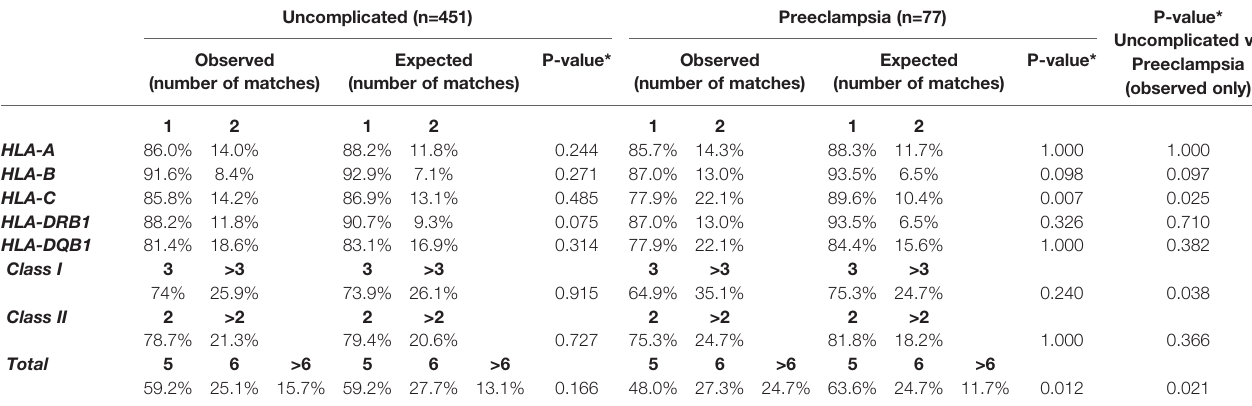
*P-values calculated by Chi-square analysis. P-values are corrected for multiple comparisons with the Bonferroni method. p < 0.05 is considered signi fi